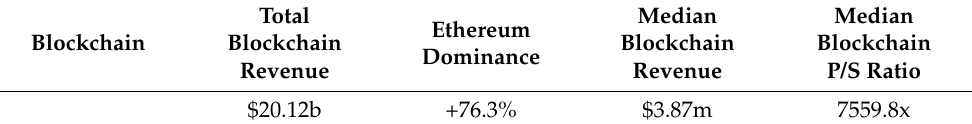
Table 6. Descriptive statistics for the blockchain class of tokens.